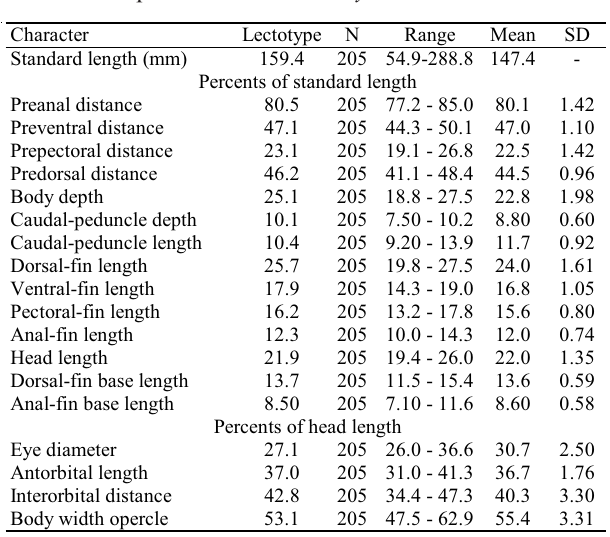
Table 6. Morphometrics of Laemolyta taeniata